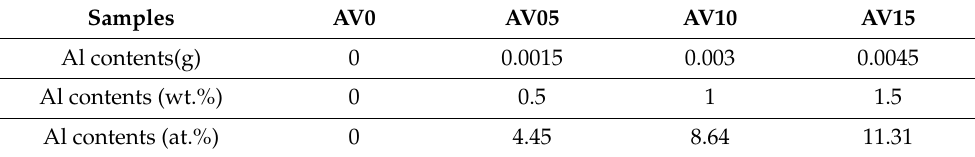
Table 1. Al at.% of the AV NSs with various Al contents